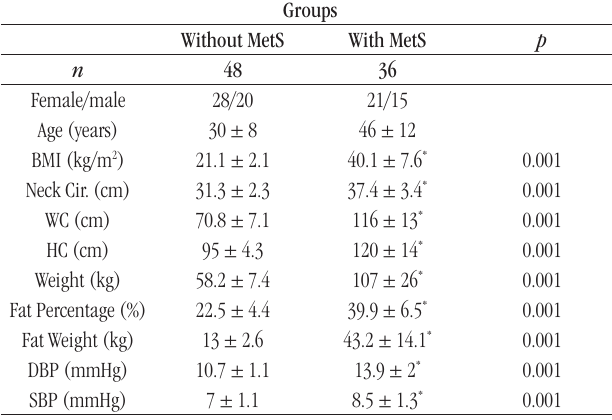
taBLE 1 − Baseline characteristics of study